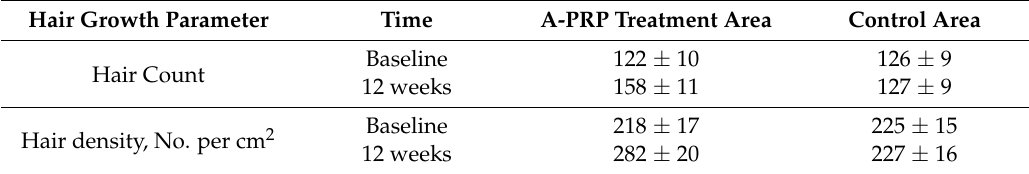
Table 1. Relevant hair-growth parameters assessed by Trichoscan analysis for the A-PRP treatment and placebo negative control half-head areas at baseline and after 12